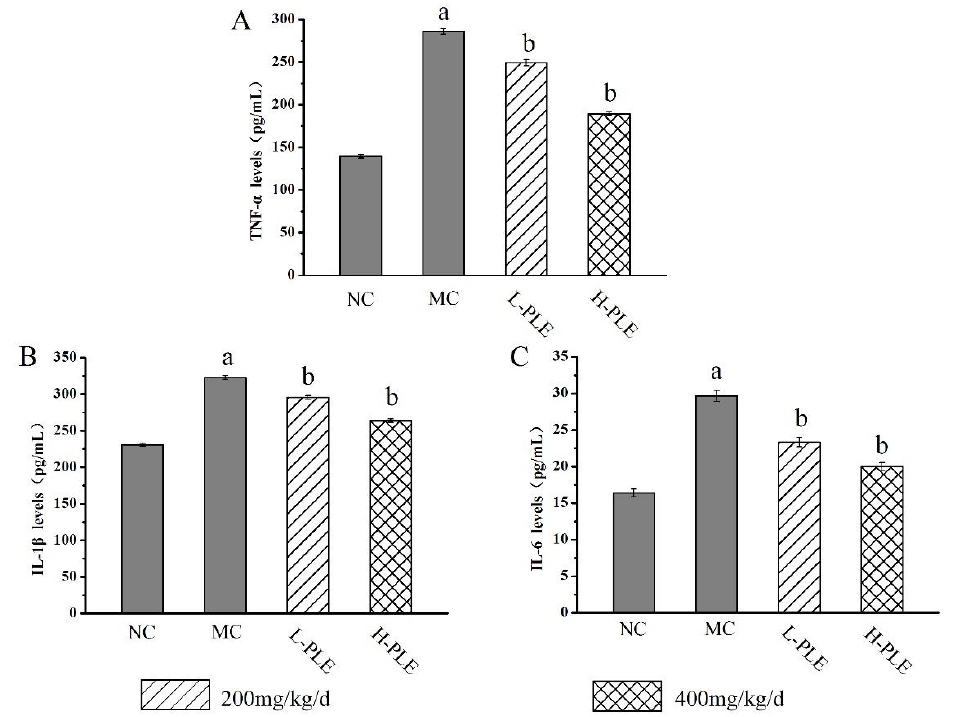
Figure 5. The effects of PLE on inflammation response in zymosan-induced ALI mice. ( A ) TNF- α levels, ( B ) IL- 1β levels, and ( C ) IL-6 levels. The values were reported as the Mean ± SD (n = 10 for